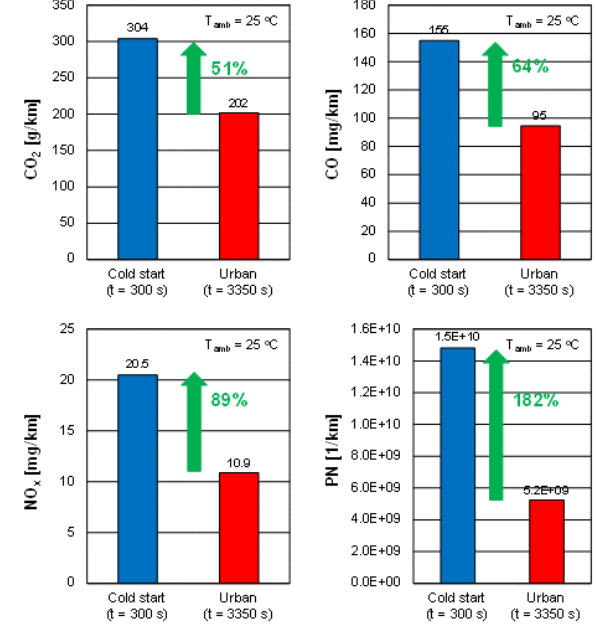
Figure 8: The on-road emissions of carbon dioxide, carbon monox- ide, nitrogen oxides, and particles number during the cold start for an ambient temperature of 8 ∘ C